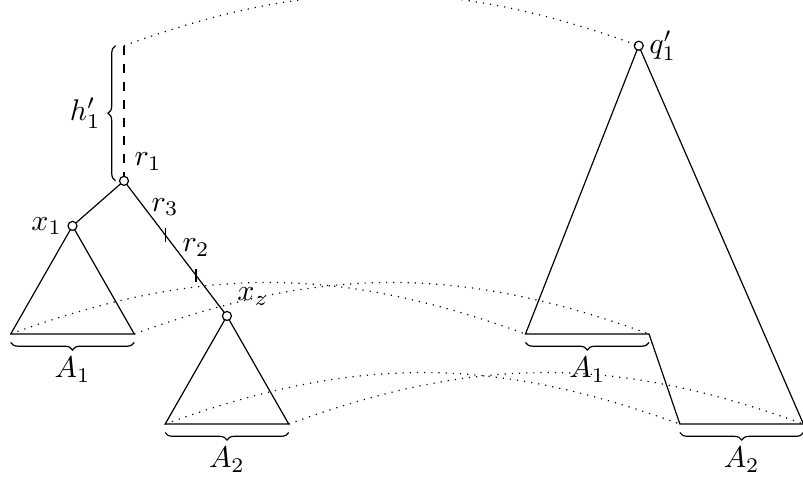
) ( right , h (cid:48) 1 1